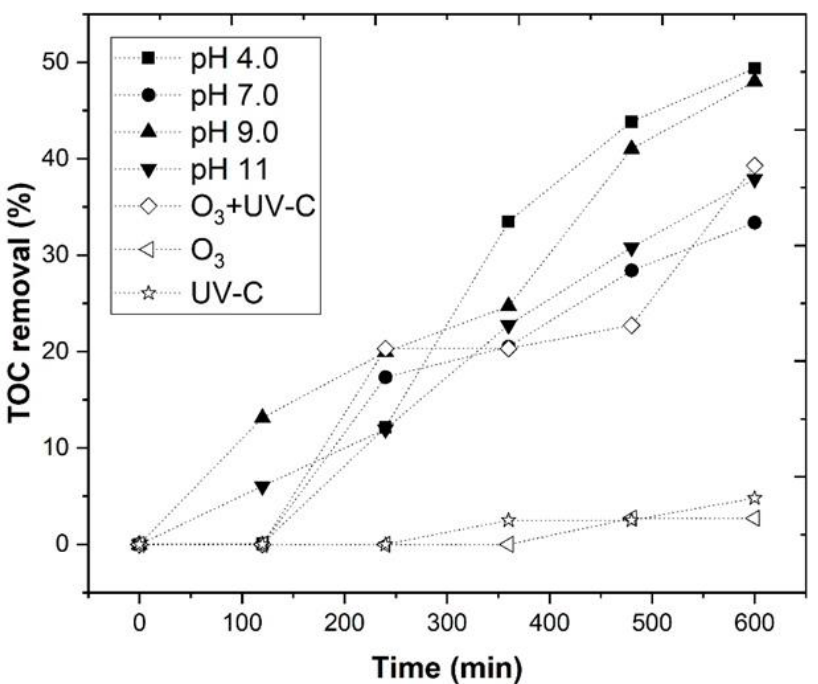
Figure 6. Evaluation of TOC removal through the O 3 /Fe 2+ /UV-C process at different pH values (4.0–11.0). The following ozonation experimental conditions: [Fe 2+ ] = 1.0 mM, ozone flow rate 5 mg/min, air flow 1.0 L/min, agitation 350 rpm, time 600 min, radiation UV-C mercury lamp (254 nm). Blank experiments (O 3 /UV-C, O 3 and UV-C—pH 4.0) are also shown as a reference.